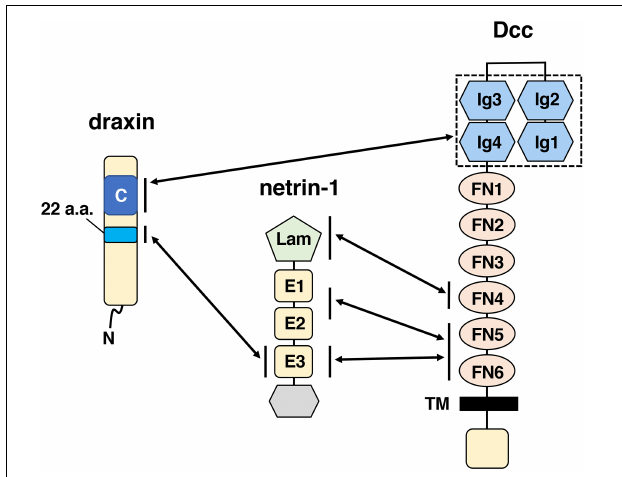
FIGURE 1 | Schematic drawings of draxin and its interacting proteins, netrin-1, and Dcc. The C-terminal domain of draxin interacts with the Ig domain of Dcc. A 22-residue sequence of draxin interacts with the EGF-3 (E3) domain of netrin-1. Netrin-1 interacts with Dcc at the fibronectin (FN) domain through three binding sites: the laminin VI domain (Lam), EGF-1/EGF-2 (E1/E2) domain, and E3 domain. It should be noted that in addition to Dcc, Neo1 is also a functionally important receptor for draxin. Because Dcc and Neo1 are structurally very similar proteins, the C-terminal domain of draxin may interact with the Ig domain of